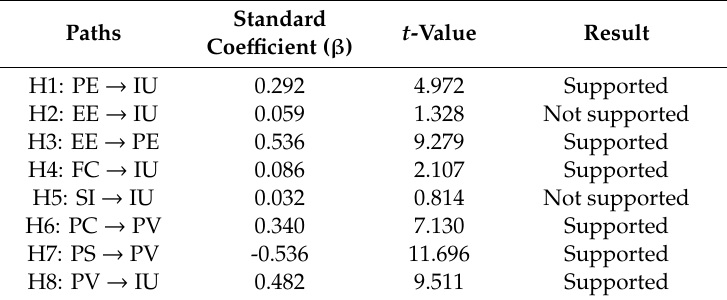
Table 4. Structural estimates and hypotheses testing results.